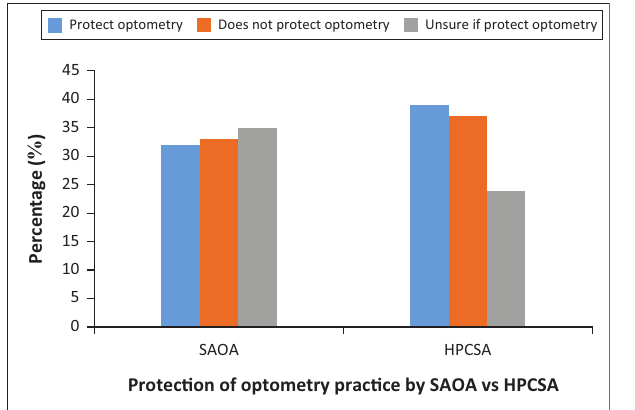
FIGURE 2: Protection of the practice of optometry by the South African Optometric Association versus the Health Professions Council of South